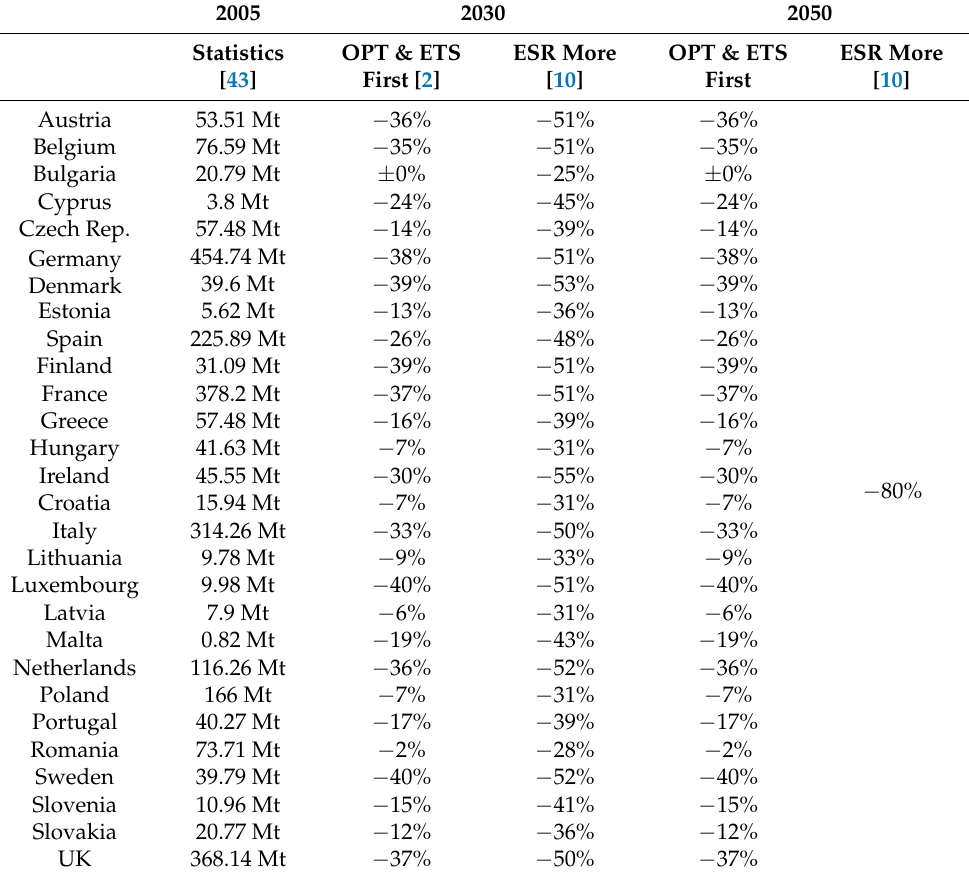
Table A1. GHG emission targets in the ESR sector for the EU27 + UK countries (extension of Table